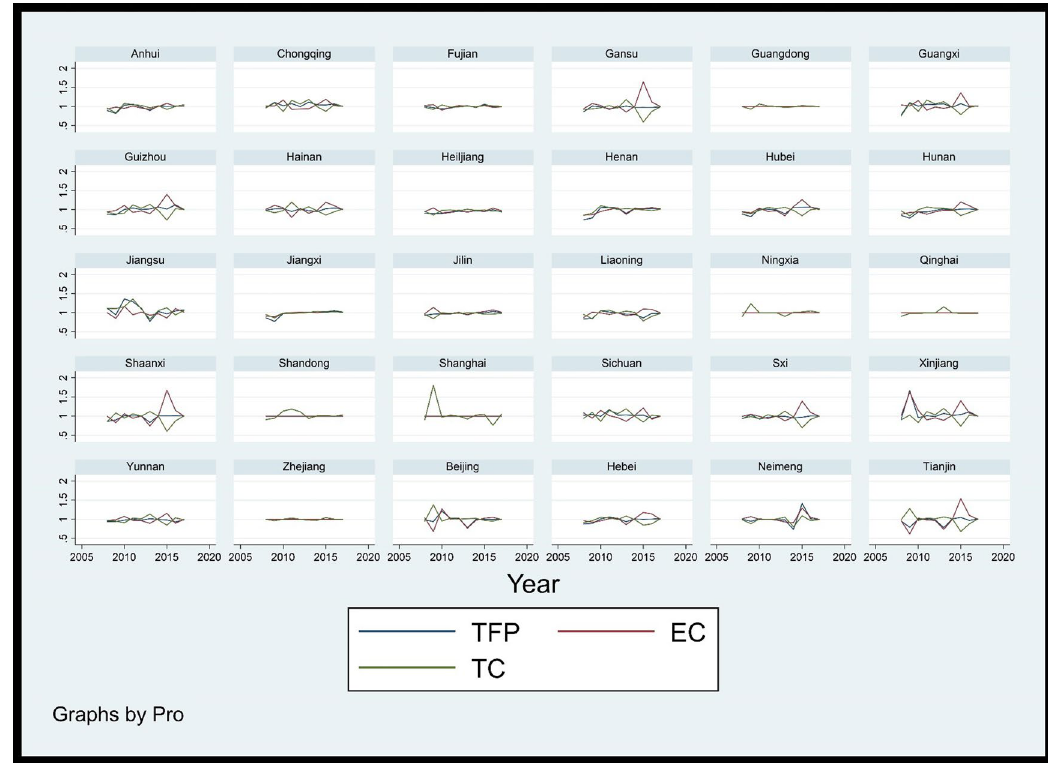
Figure 4. Change trend of TFP and decomposition indexes of forestry